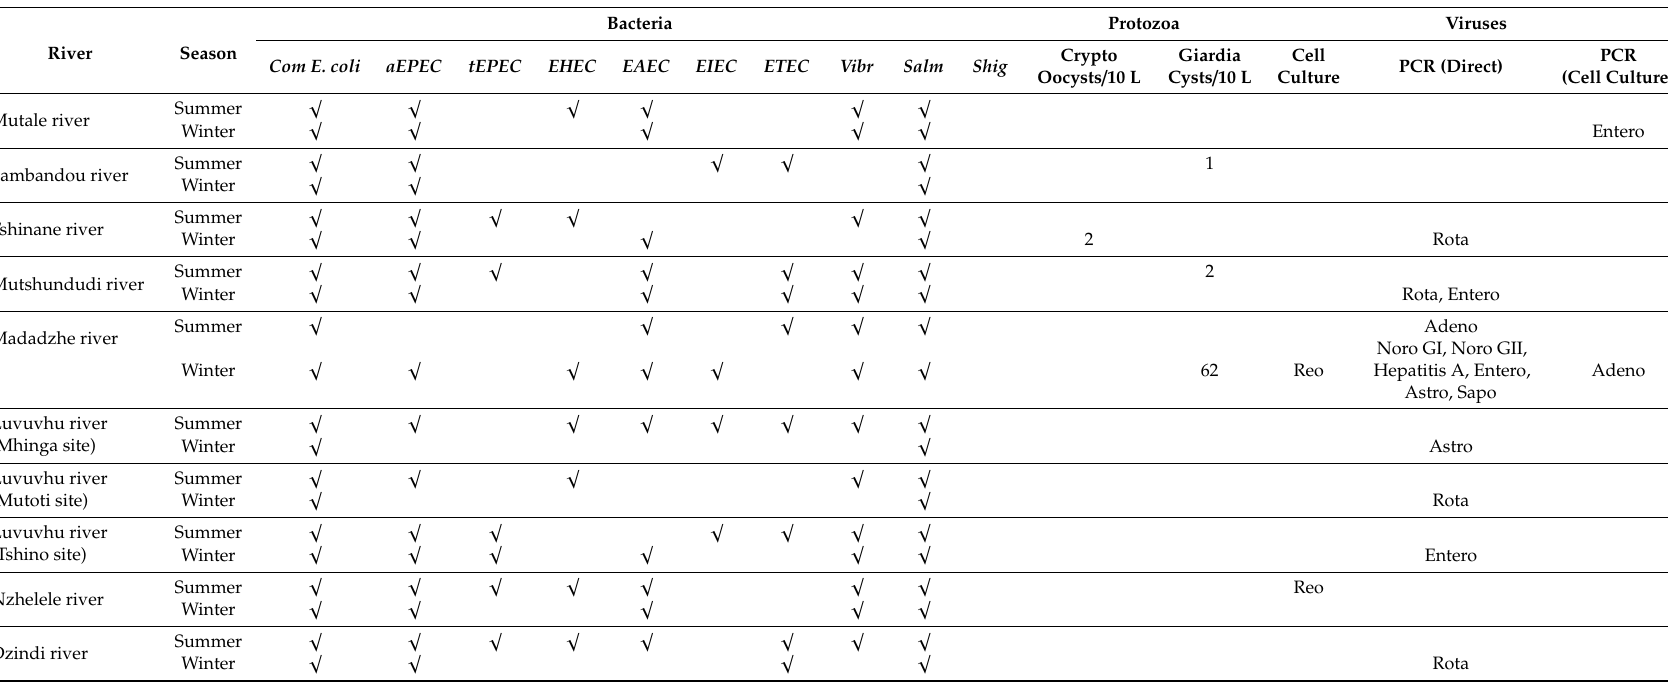
Table 3. Pathogenic bacteria, protozoa and virus pathogens isolated in various rivers in the Limpopo province, South Africa.